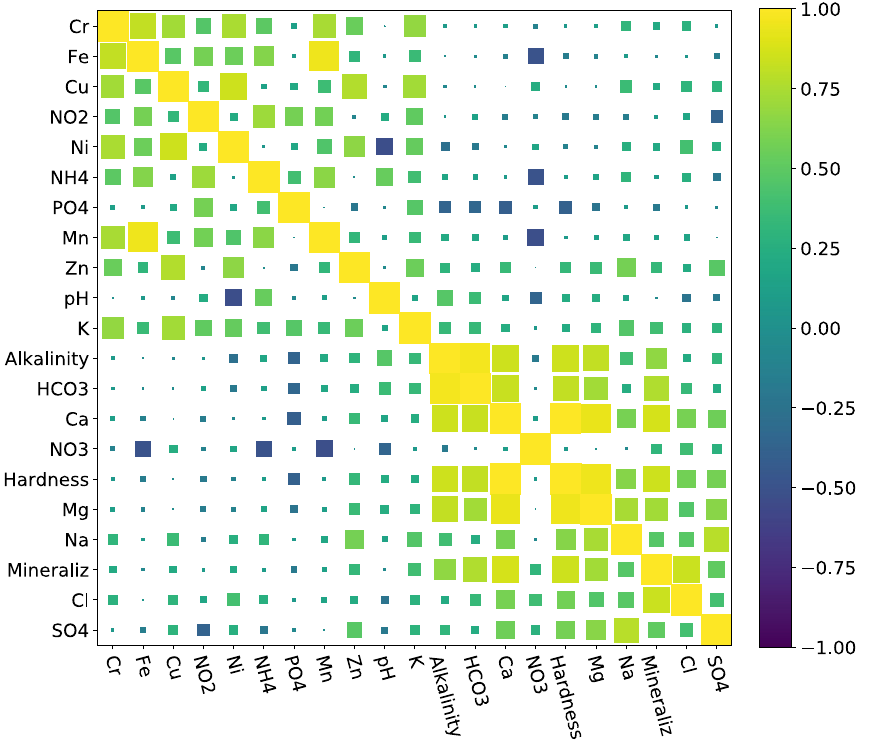
Figure 6. Pearson correlation matrix for the modeled properties derived from the optimized K f covariance matrix. Yellow (dark blue) color denotes positive (negative) correlation, whereas wide (narrow) boxes represent strong (weak)